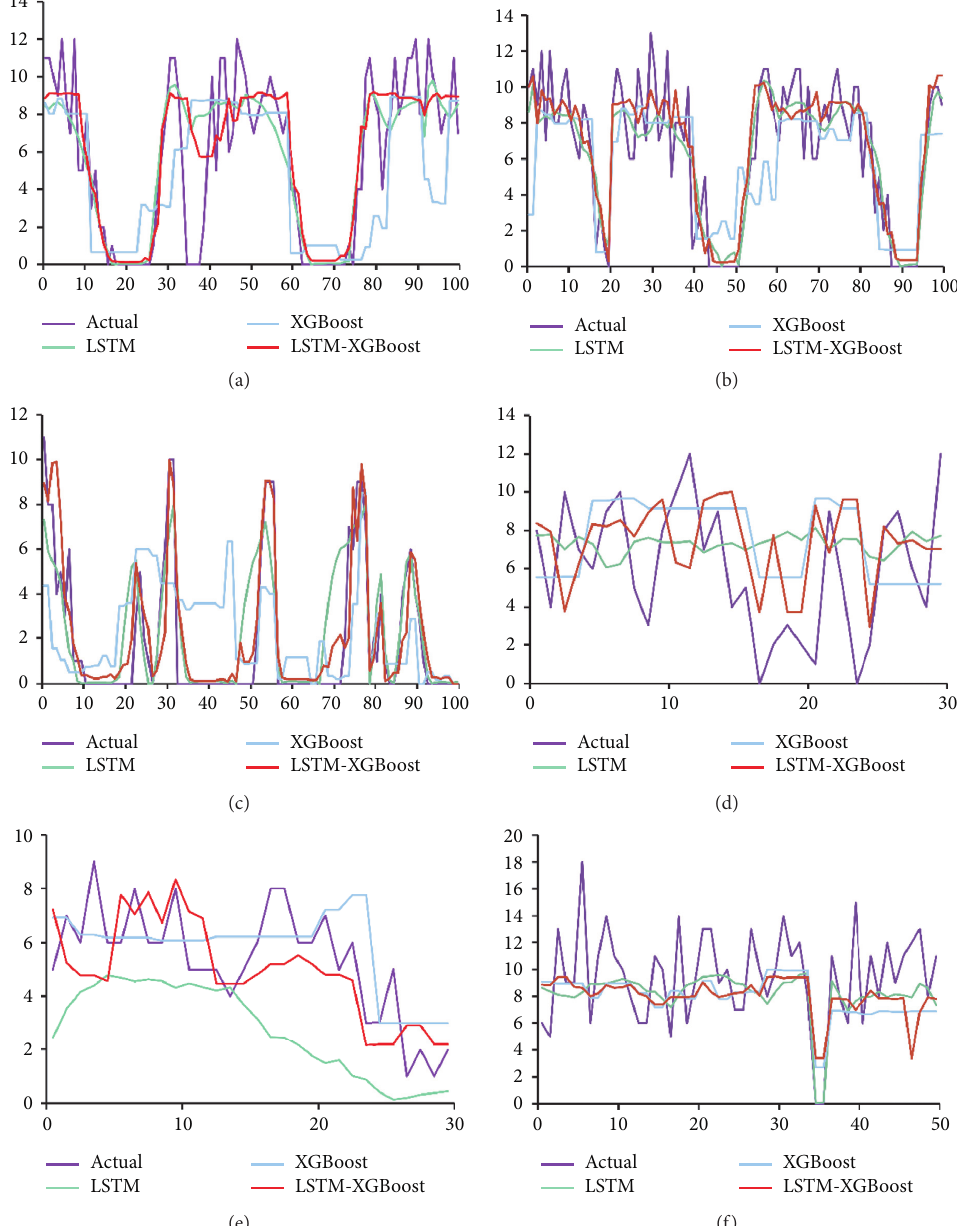
Figure 7: Comparison of model performance under various weather conditions. (a) Sunshine. (b) Rain. (c) Fog. (d) Thunder. (e) Snow. (f)